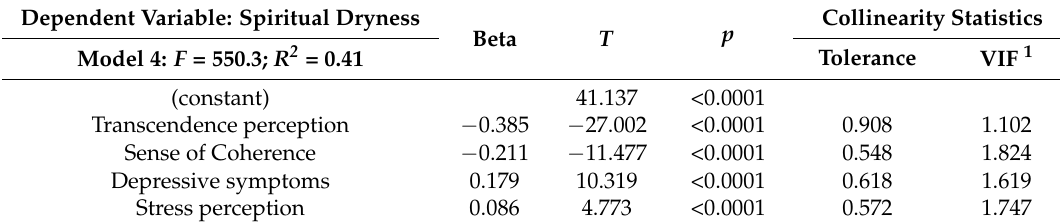
Table 3. Predictors of spiritual